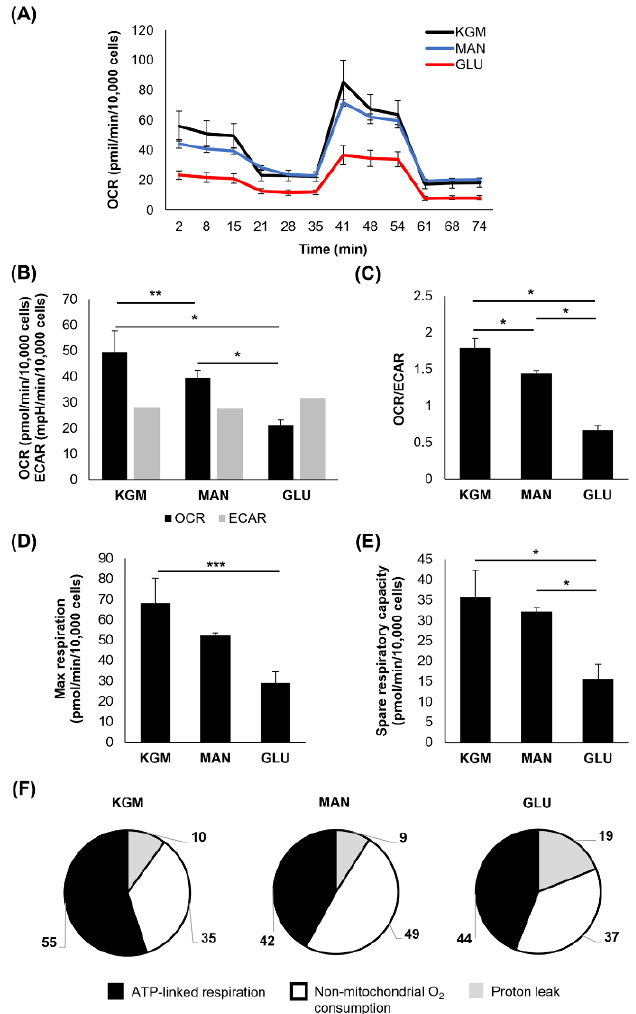
Figure 5. Prolonged hyperglycemia shifted cells toward a more glycolytic phenotype. ( A ) OCR plotted as a function of time for both test and control groups. ( B ) OCR was decreased in high glucose compared to KGM and mannitol (* p < 0.001, ** p = 0.005). There were no differences in ECAR between groups ( p = 0.069). ( C ) The OCR/ECAR ratio was shifted toward a more glycolytic phenotype for cells cultured in high glucose (* p < 0.001). ( D ) Maximal respiration was decreased in glucose-treated cells (*** p < 0.05). ( E ) Spare respiratory capacity was similarly reduced in glucose-treated cells (* p < 0.001). ( F ) The proportion of oxygen consumption due to ATP-linked respiration, non-mitochondrial oxygen consumption, and the proton leak in the KGM control compared to glucose- and mannitol-treated cells. Bar graphs are presented as mean ± standard deviation. Pie charts are presented as percentage of total oxygen consumption. Graphs are representative of one experiment that was repeated three independent times. One-way ANOVA on ranks with Dunn’s post hoc comparison test (maximal respiration) and one-way ANOVA with SNK multiple comparison test for all